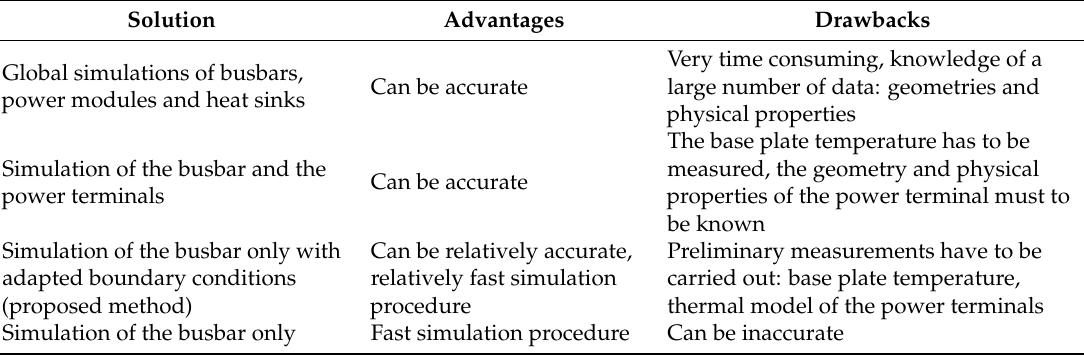
Table 6. Comparison of different modelling